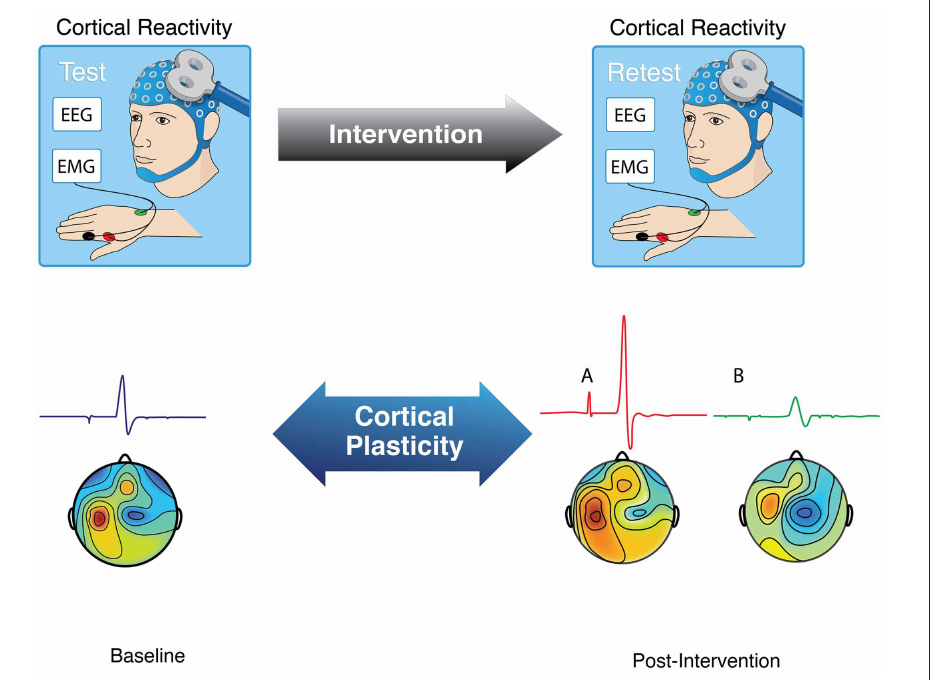
FIGURE 2 | Schematic representation of how to assess brain plasticity with TMS. As recorded using either electromyography (EMG) or electroencephalography (EEG), brain responses to TMS can be measured as motor evoked potentials (when TMS is applied to motor cortex) or localized evoked field potentials. Comparison of these TMS-based measures of cortical reactivity before and after a given intervention (e.g., PAS, rTMS, TBS, task) can provide an index of brain plasticity in response to that